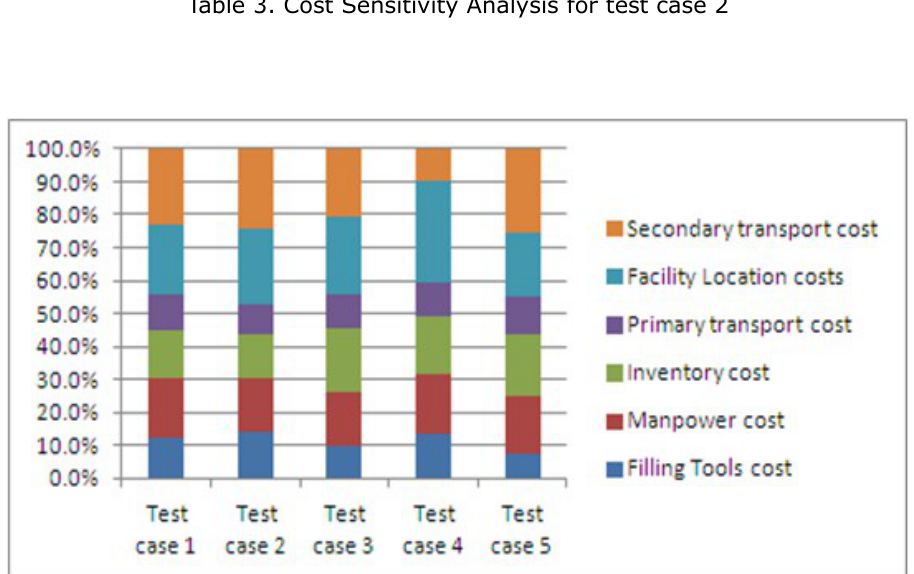
Figure 7. Network Design Costs for 3 test cases